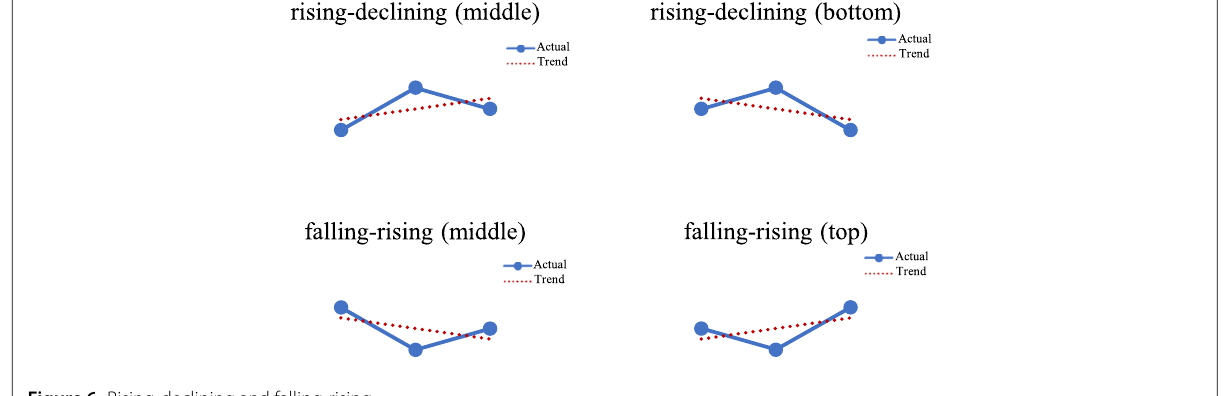
Figure 6 Rising-declining and